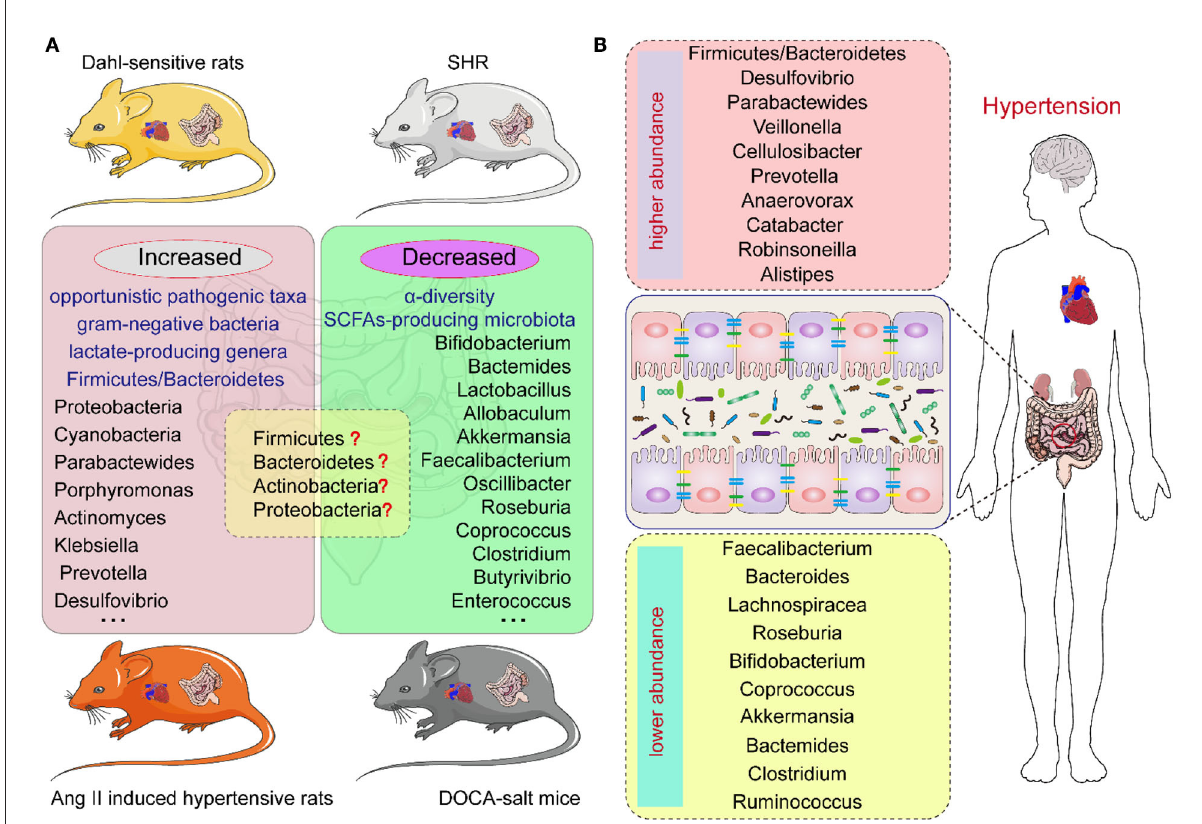
FIGURE1 The intestinal microbiota composition in hypertension animal models and human individuals of hypertension. (A) The intestinal microbiota changes in different hypertension animal models. (B) The intestinal microbiota changes in hypertension